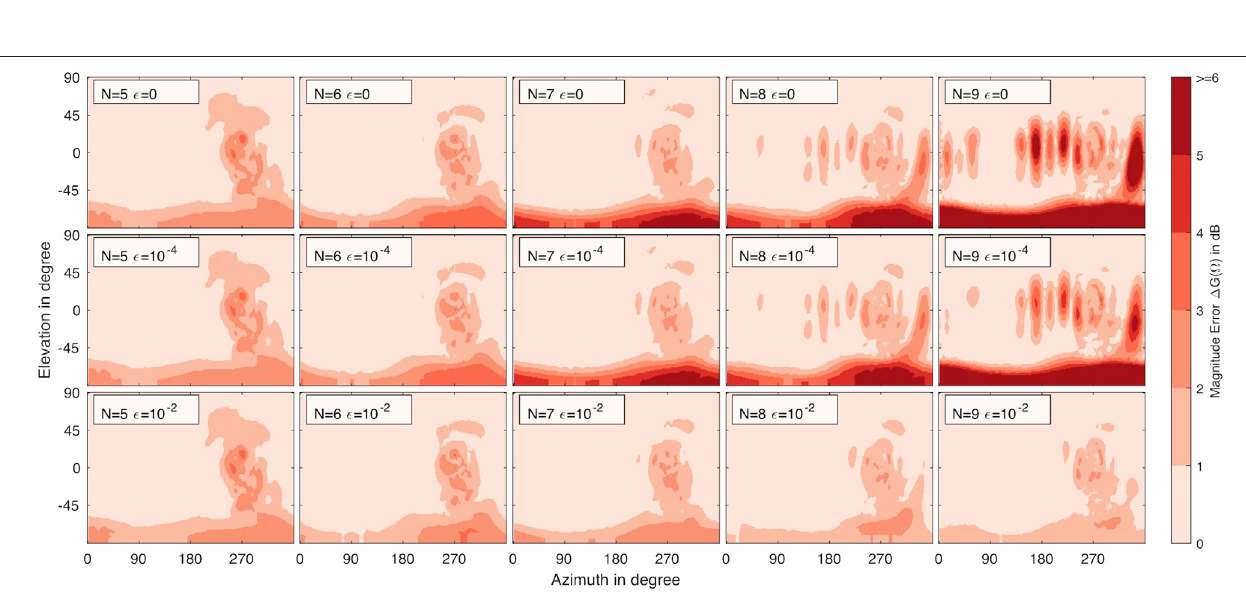
Frontiers in Signal Processing |